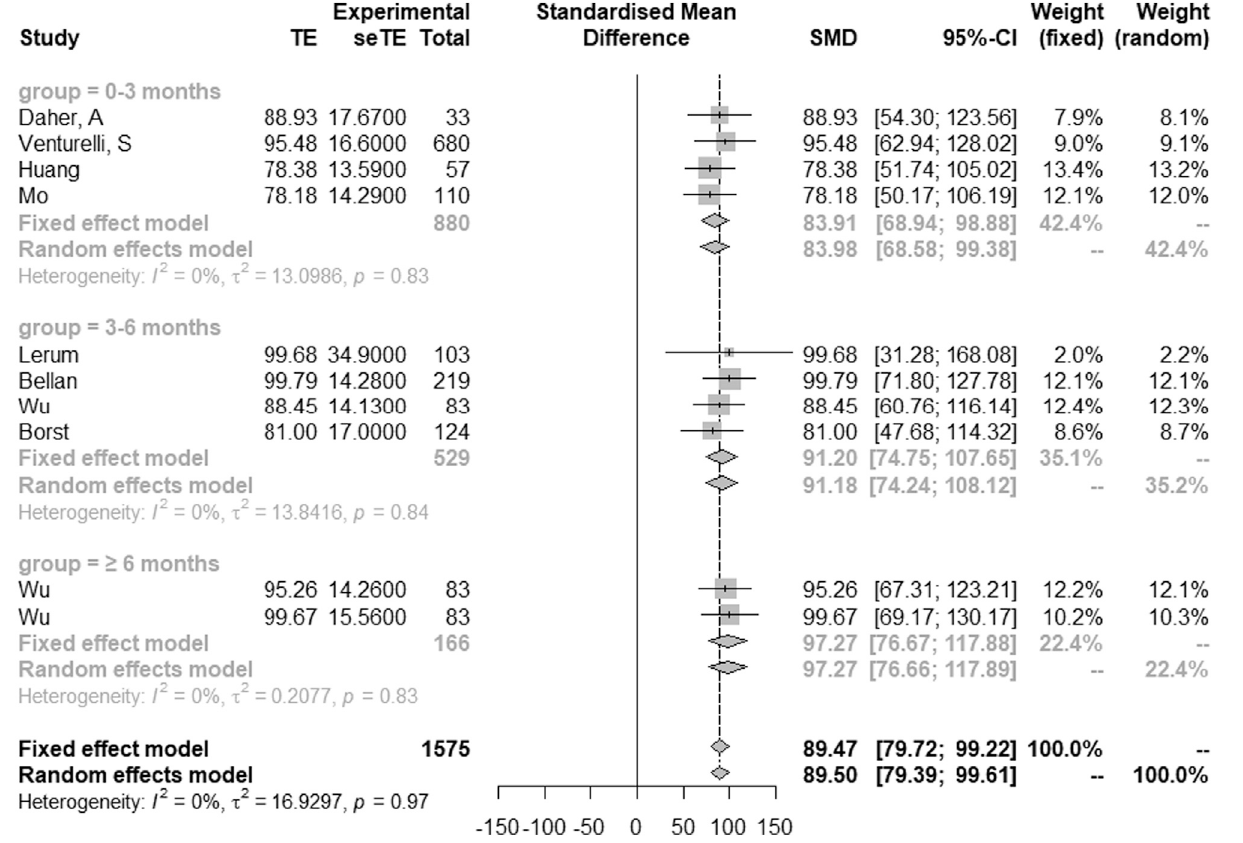
Frontiers in Molecular Biosciences |